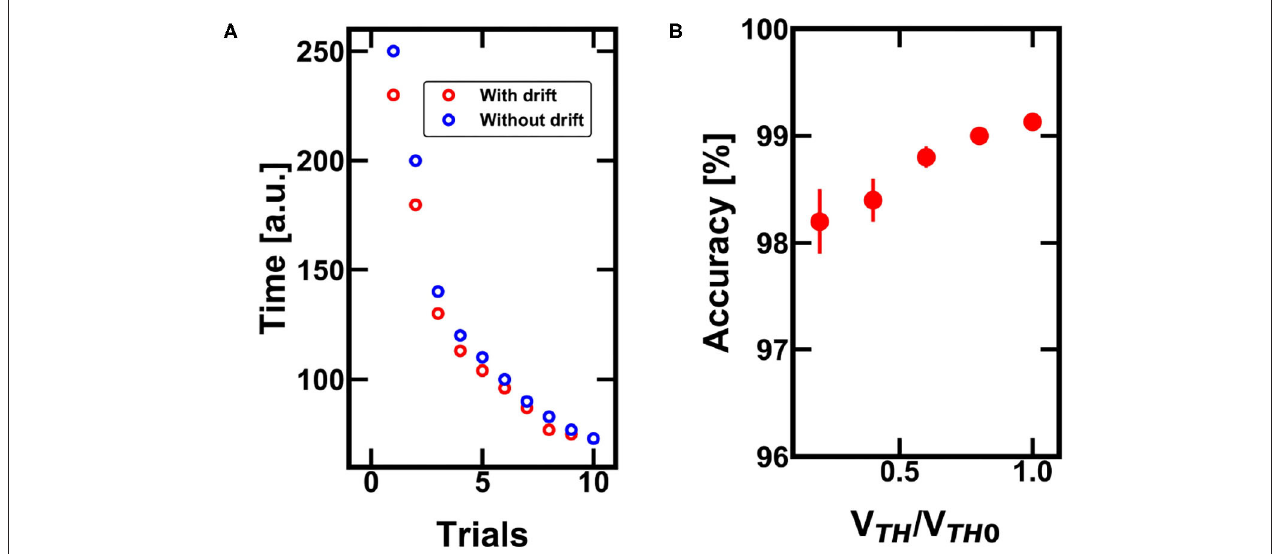
FIGURE 9 | (A) Monte Carlo simulations of the minimum time needed to successfully find the escape path with and without the drift effect of the PCM devices. The larger the drift, the lower the time to get to the final reward. (B) Impact of the drift on the accuracy for finding the escape path over 1,000 trials of the same experiment. Note that the drift is not a benefit since the decreasing V TH (with respect to the nominal V TH 0 ) can lead to misunderstanding in the policy map definition.